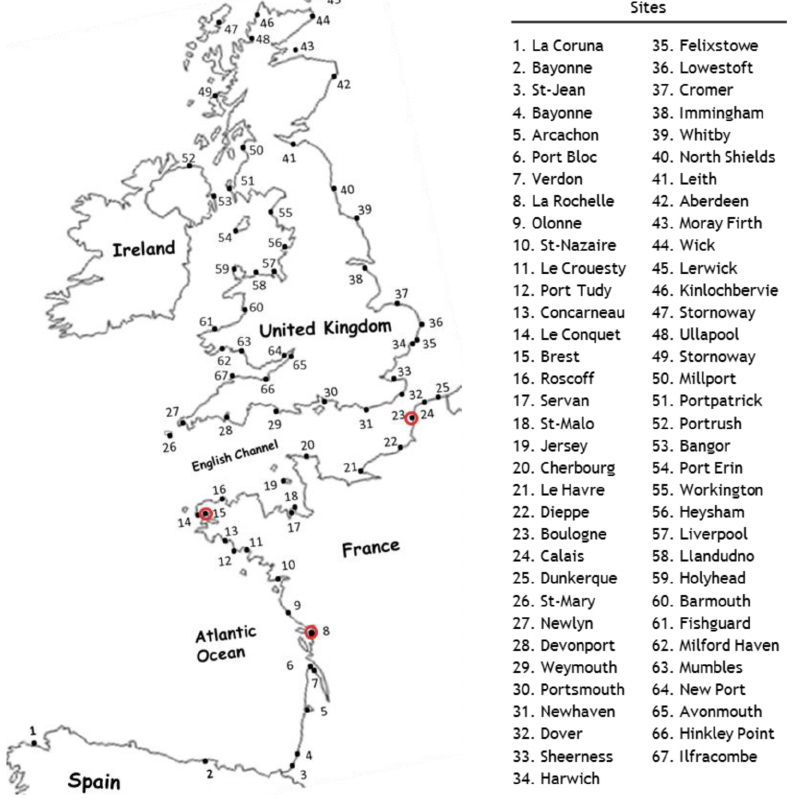
Figure 2. Location of sites used for the study: 67 ports along the Spanish, French, and British coasts. Each site is associated with a number. The table on the right shows the correspondence between numbers and sites. The circled points represent the target sites for which a centered RFA is carried out in this